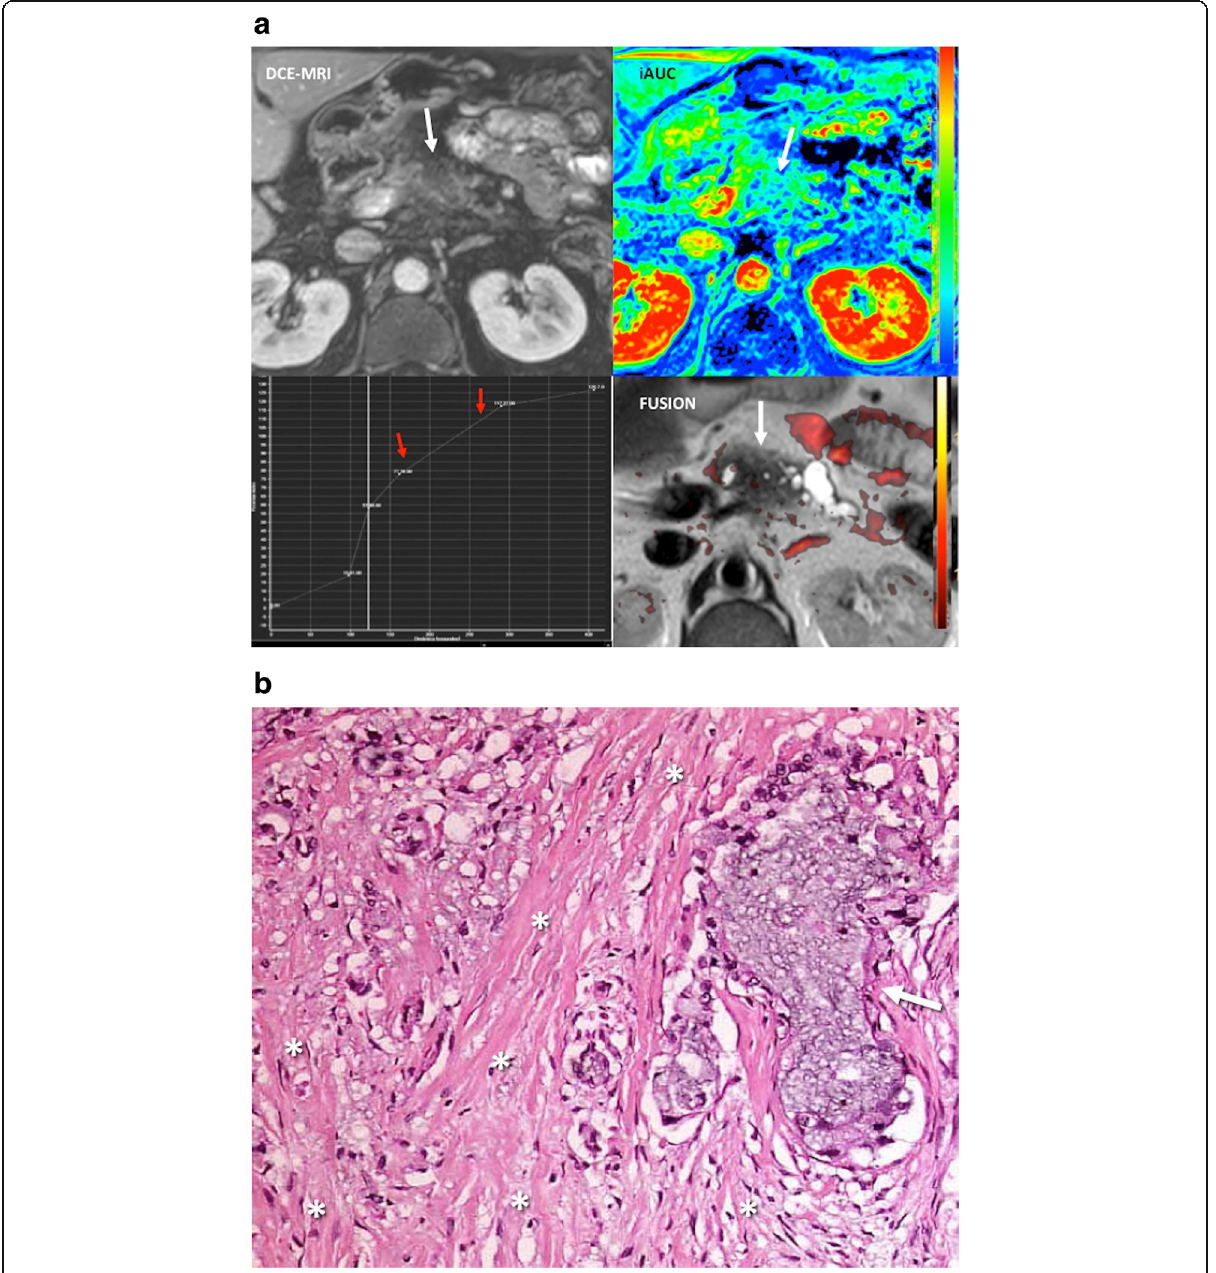
Fig. 9 Desmoplastic reaction in a 51-year-old patient with pancreatic adenocarcinoma. a Imaging evaluation including an axial fat-suppresed contrast-enhanced T1-weighted dynamic MR image (DCE-MRI, top, left), a time/signal intensity curve analysis (botton, left), a parametric map corresponding to the initial area under the curve (iAUC), and a fusion of axial T2-weighted image fused with a superimposed color-coded map derived from high b value DWI (FUSION) clearly showed a hypoperfunded mass with a pattern of progressive enhancement (curve type 1, red arrows) and no restricted diffusion in the tumor in the fusion image. These findings were secondary to the predominance of fibrosis within the lesion. b Histological analysis (H&E, × 20) confirmed an abundant tumor desmoplastic reaction (asterisks) with clusters of tumor cells